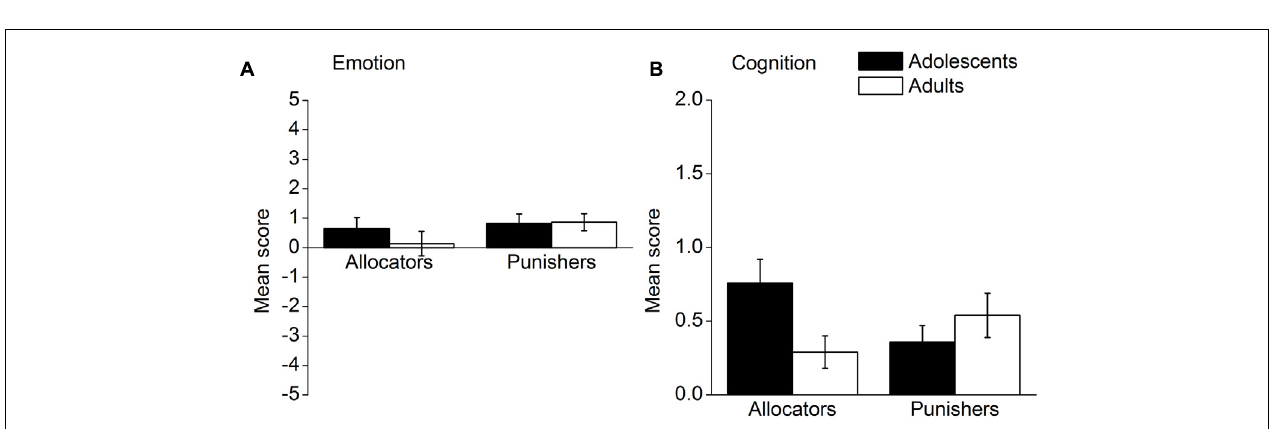
FIGURE 3 | Altruistic punishment in the two rounds for males and females; (A) mean MUs adolescent punishers used, (B) mean MUs adult punishers used. Error bars represent standard error.